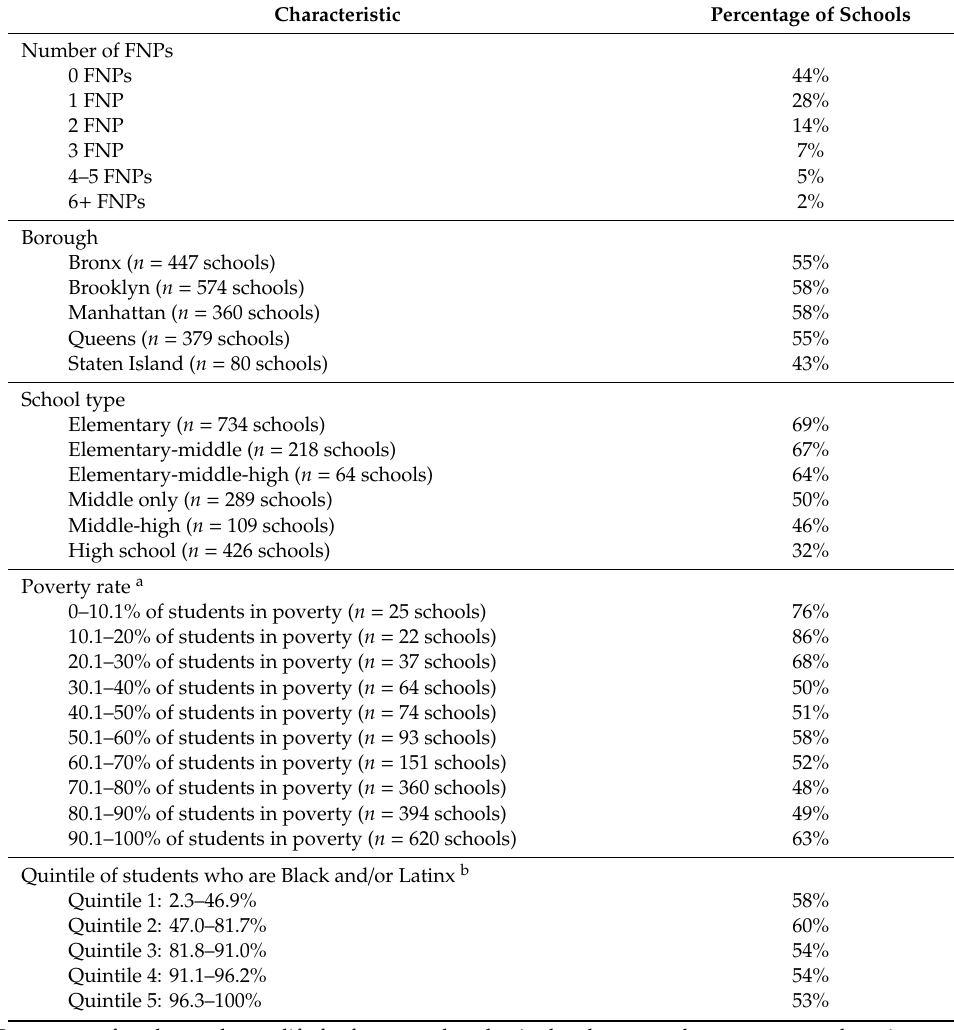
Table 6. Characteristics of Schools Partnering with Food and Nutrition Education Programs during the 2016–2017 School Year ( n = 1840 schools, n = 101 programs). Characteristic Percentage of Schools Number of